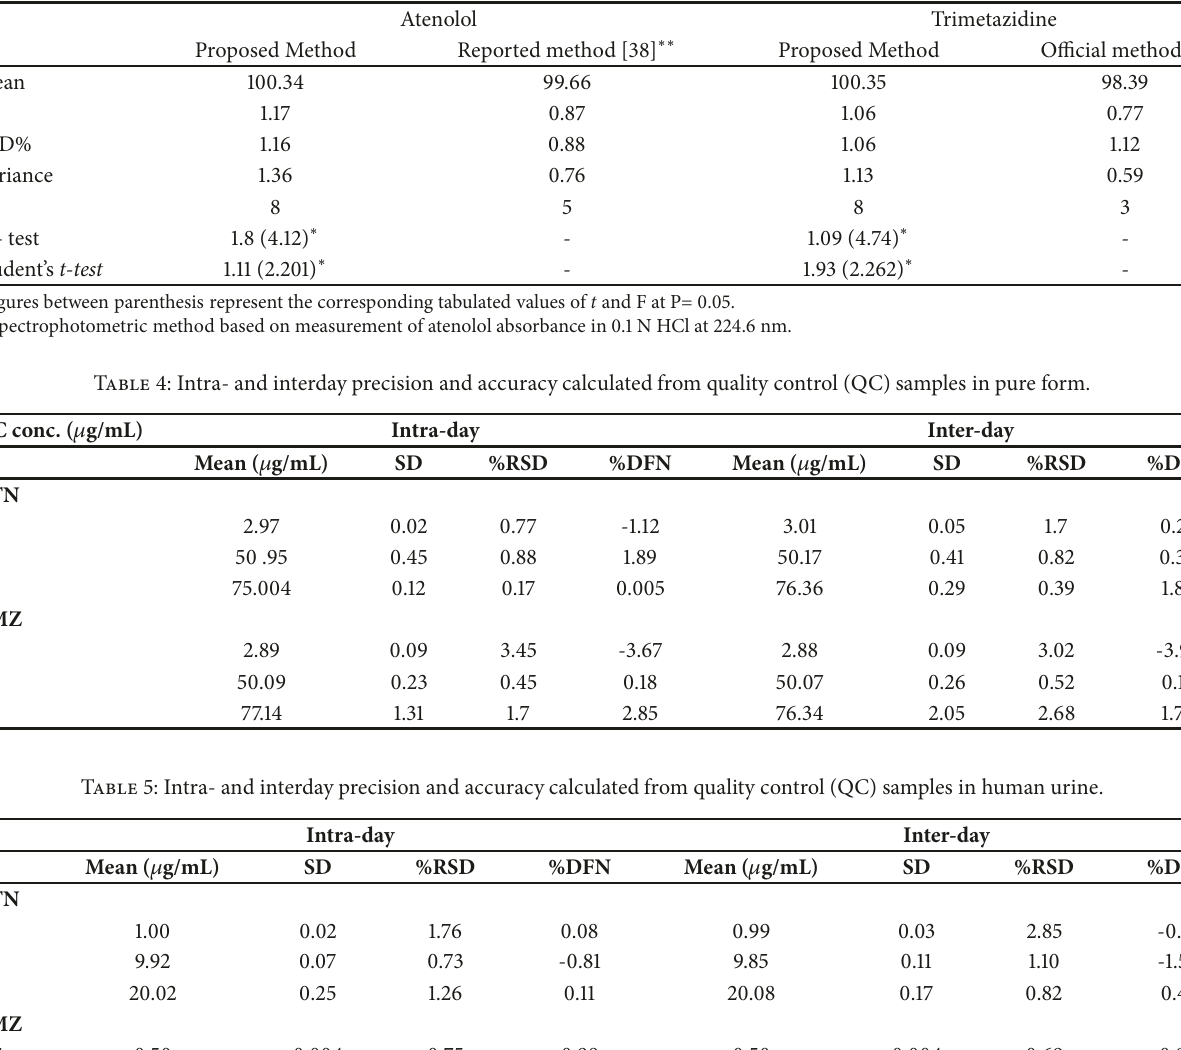
Table 3: Statistical analysis of the proposed method in standard solution and the official/reported methods [1, 38].